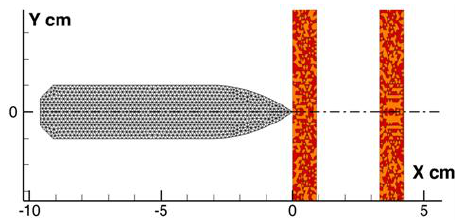
Fig. 7. The geometry of the 3D problem of perforation of a barrier from two spaced heterogeneous plates at distance of 24 mm. Projectile – hard steel, plates – mixture mild steel with ceramic B 4 C 50% volume